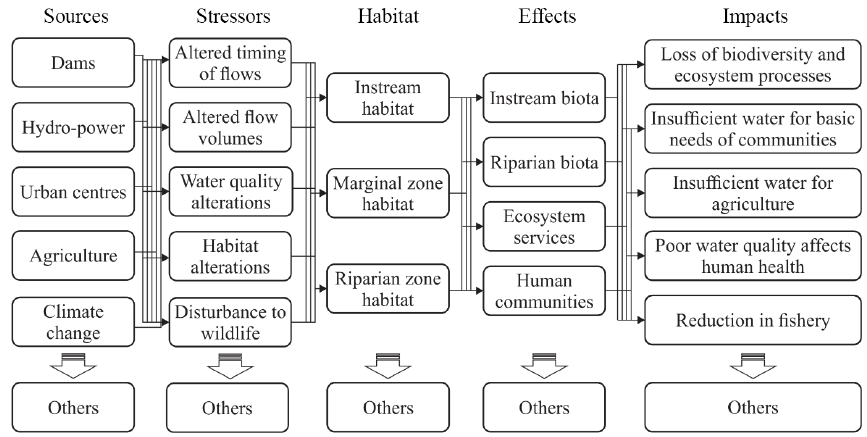
Figure 4. Example of a holistic conceptual model established in a PROBFLO case study that describes causal risk relationships (arrows) between sources, stressors, habitats, effects and impacts to endpoints considered in an